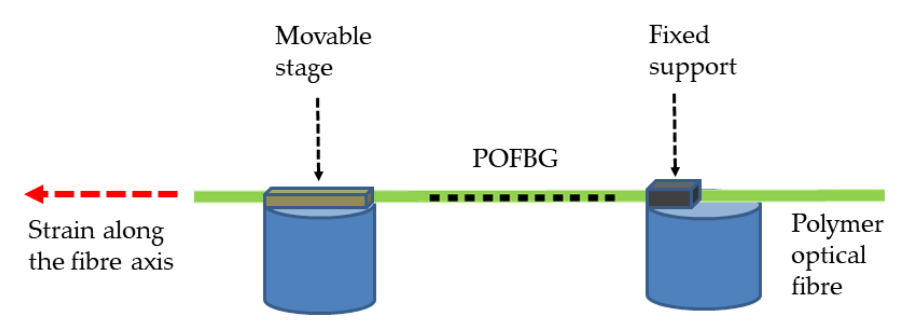
Figure 4. Setup for the strain characterisation of POFBG sensors.